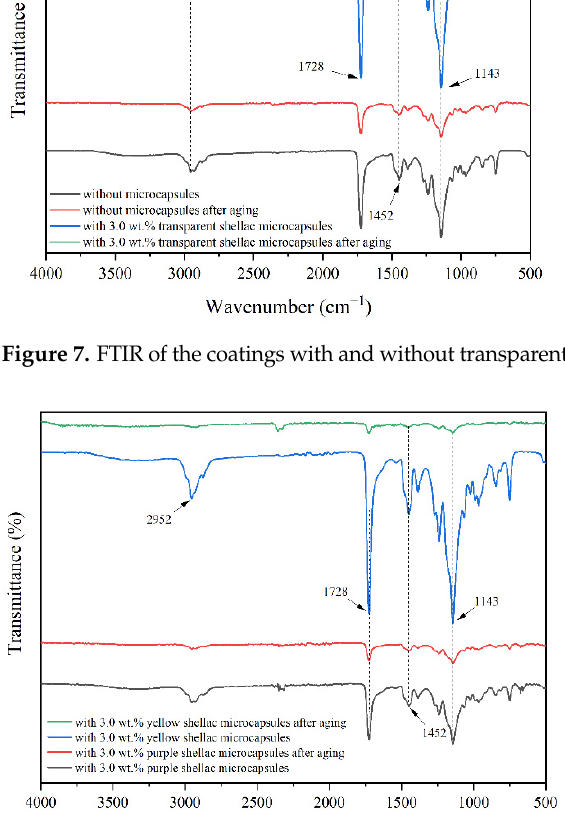
Figure 8. FTIR of the coatings with purple and yellow shellac microcapsule before and after aging.